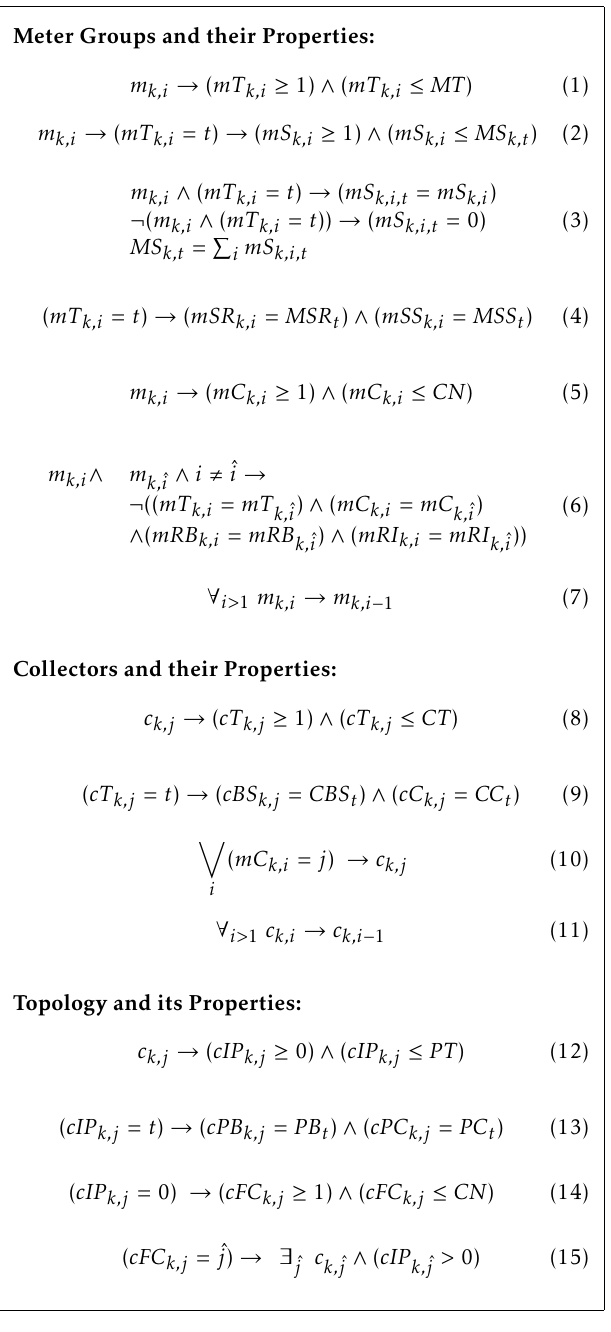
Table 2. Meter, Collector, and Topology